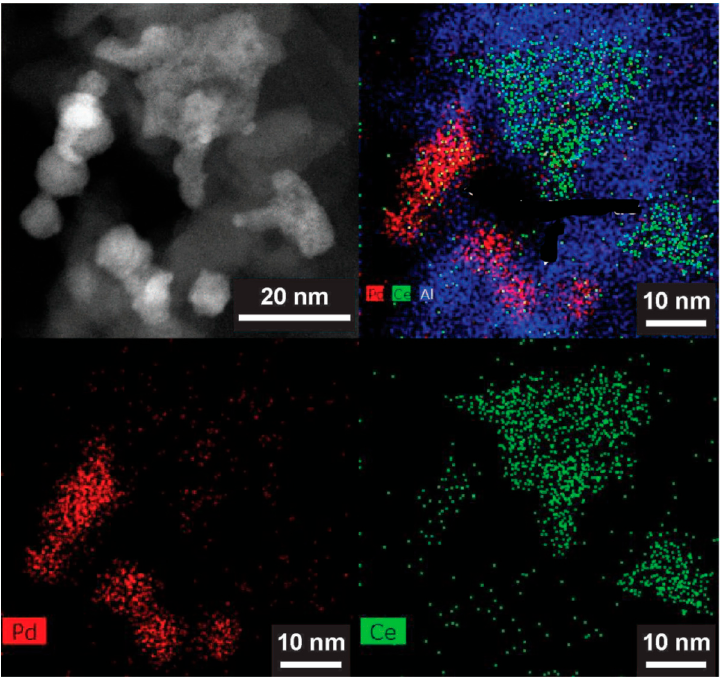
Figure 4. HAADF-STEM image and EDS mapping of 4Pd-20CeO 2 / Al 2 O 3 catalyst. ( top left ) STEM image; ( top right ) EDS overlapped mapping; ( bottom left ) EDS mapping of Pd; ( bottom right ) EDS mapping of Ce. Pd, Ce, and Al are color coded as red, green, and blue, respectively.